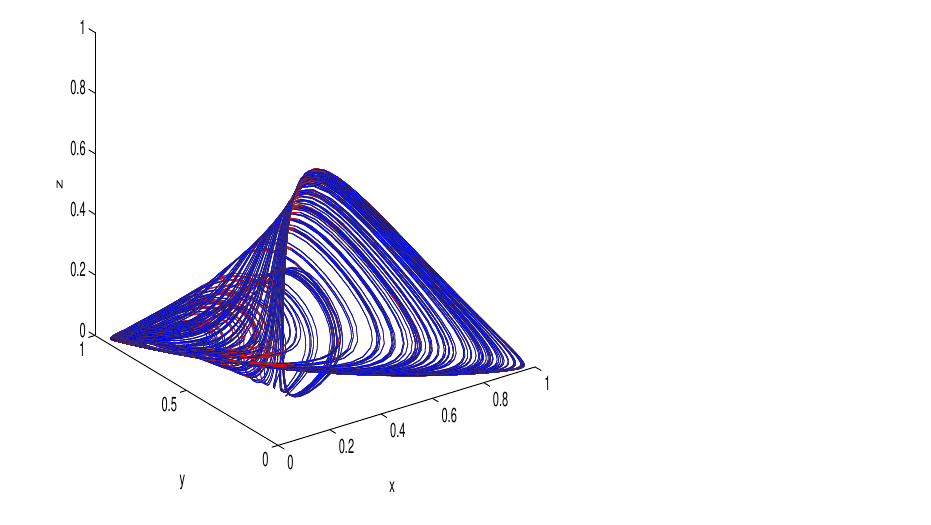
Figure 1. Cancer attractor with x 0 = 0.1, y 0 = 0.1, z 0 = 0.1 and parameter values r 2 = 0.6, r 3 = 4.5, a 12 = 1, a 21 = 1.5, a 13 = 2.5, a 31 = 0.2, k 3 = 1, d 3 = 0.5.